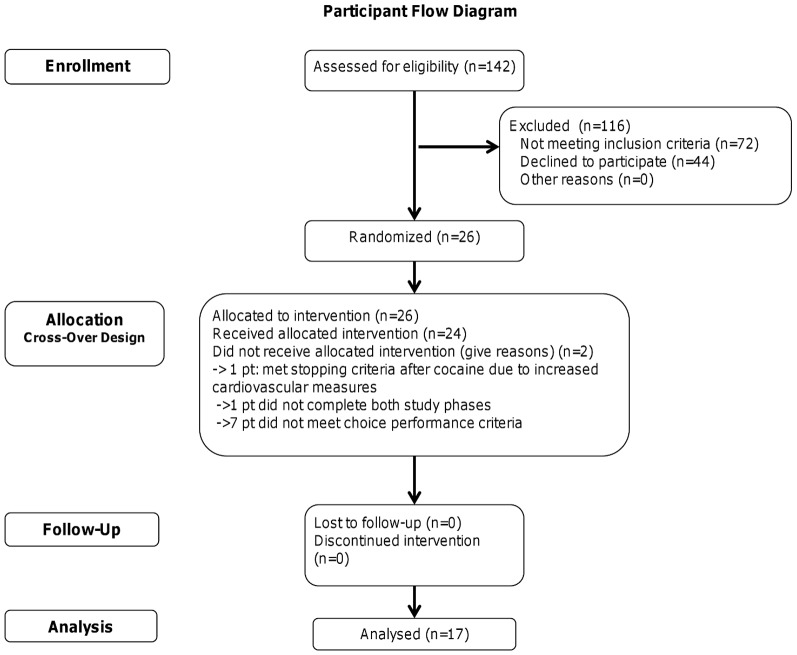
CONSORT Flowchart.